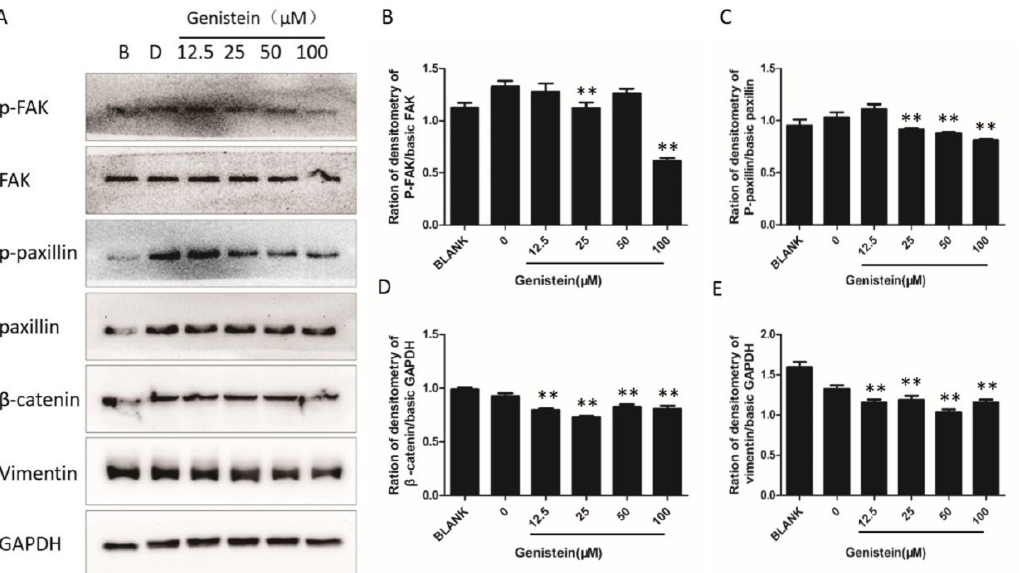
Figure 12. Effect of genistein on the focal adhesion protein expression in HeLa cells. ( A ) Cells were grown with or without different doses of genistein for 30 min. The expression levels of specific proteins were detected by Western blot analysis. GAPDH was used as a control. All first antibodies were used at a dilution of 1:1000. Secondary antibodies were used at a concentration of 1:3000. ( B – E ) Integrated optical intensity of the bands was determined by Image J software (https://imagej.net, accessed on 3 January 2023). The experiment was repeated three times. ** p < 0.01 vs. DMSO control.